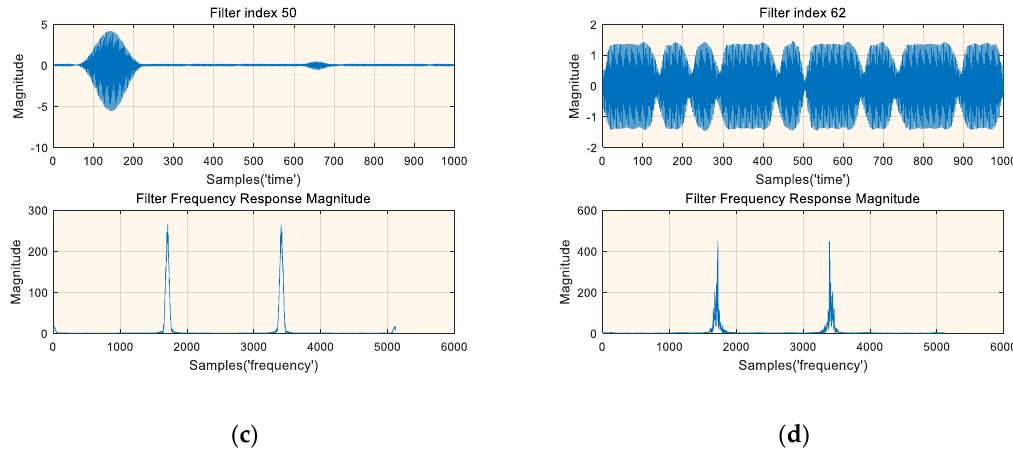
Figure 11. Time and frequency magnitude representations of the signals that most activate the four selected filters, ( a ) Time and frequency magnitude representations of the signals that most activate filter 26 taps, ( b ) ime and frequency magnitude representations of the signals that most activate filter 34 taps, ( c ) ime and frequency magnitude representations of the signals that most activate filter 50 taps, ( d ) ime and frequency magnitude representations of the signals that most activate filter 62 taps.